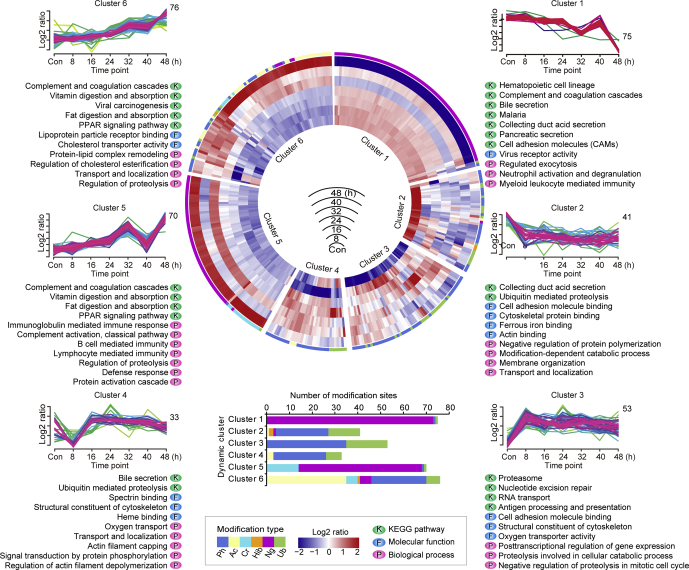
Dynamic cluster heatmap of modification sites with significant changes (348 modification sites, FDR < 0.01) of RBC proteins. The circular heatmap in the middle represents the abundance variation of each modification site of healthy RBC proteins and of P. falciparum−infected RBC proteins over time from 8, 16, 24, 32, 40, and 48 h after invasion. The redder the color, the higher the abundance. The bluer the color, the lower the abundance. The six sections of the heatmap correspond to the six clusters based on the abundance trends of modification during the IDC, and the main function terms enriched in each cluster are displayed below the graphs. The function entries were enriched from KEGG pathways (represented by “K”) and GO terms, which were divided into three categories: cell components (not shown in the figure), molecular function (represented by “F”), and biological process (represented by “P”). FDR, false discovery rate; GO, Gene Ontology; IDC, intraerythrocytic development cycle; KEGG, Kyoto Encyclopedia of Genes and Genomes.